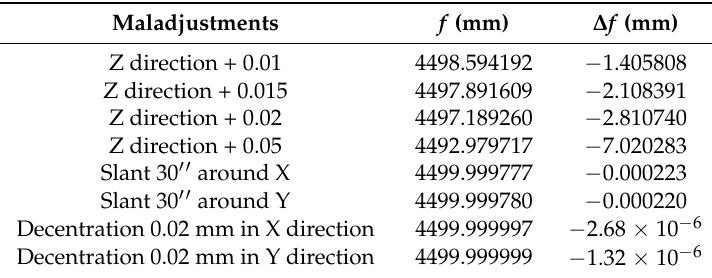
Table 1. Simulation calculation results using ground method.